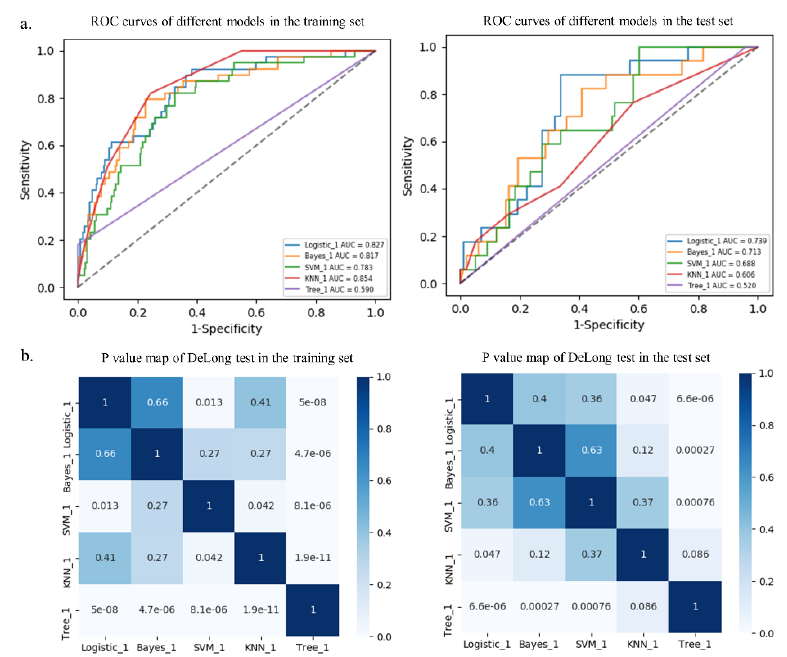
Figure 5. Receiver operating characteristic (ROC) curves of different models in the training and test sets ( a ). P value map of DeLong test in the training and test sets ( b ).